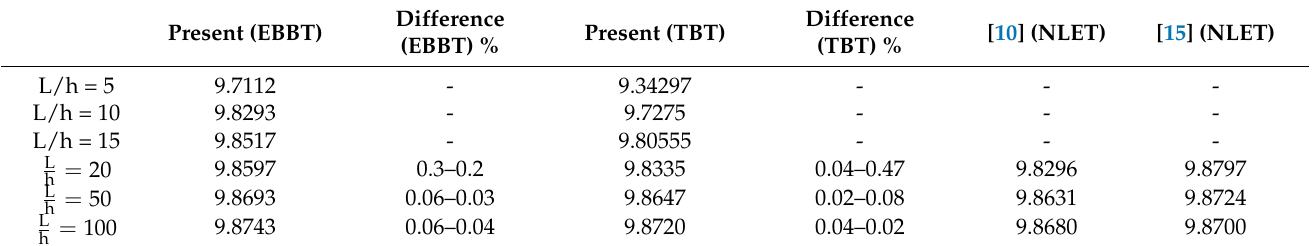
Table 1. Comparison of dimensionless frequency for different values of slenderness ratio.